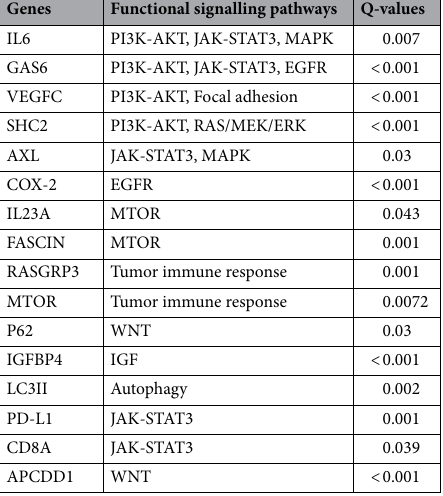
Table 1. List of potential target genes selected based on bioinformatics analysis of functional pathways contributing to radioresistance in EMT6 RR_MJI